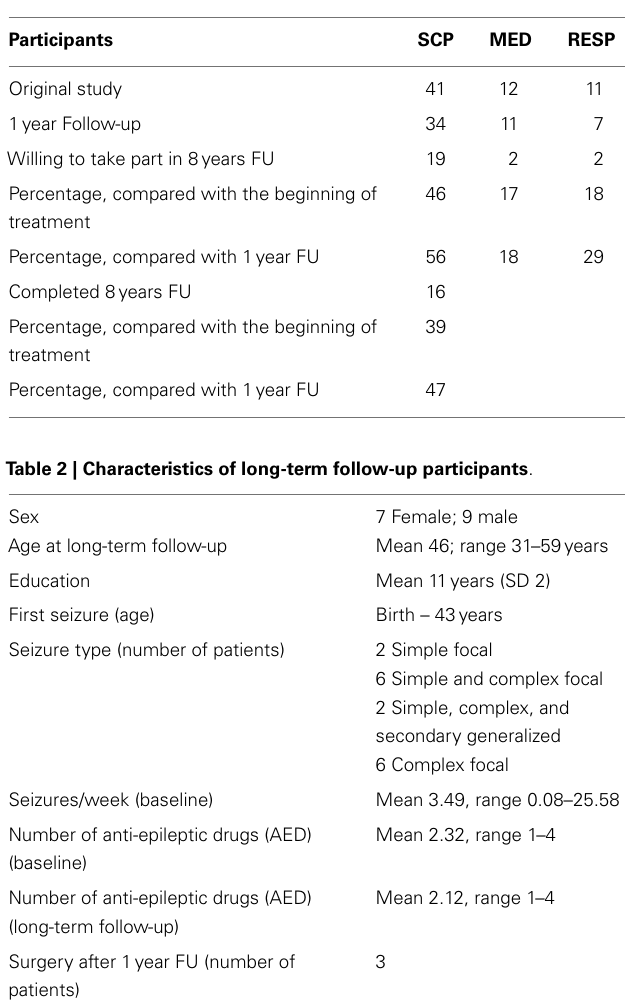
Table 1 | Participants in the original study and the follow-up evaluations .